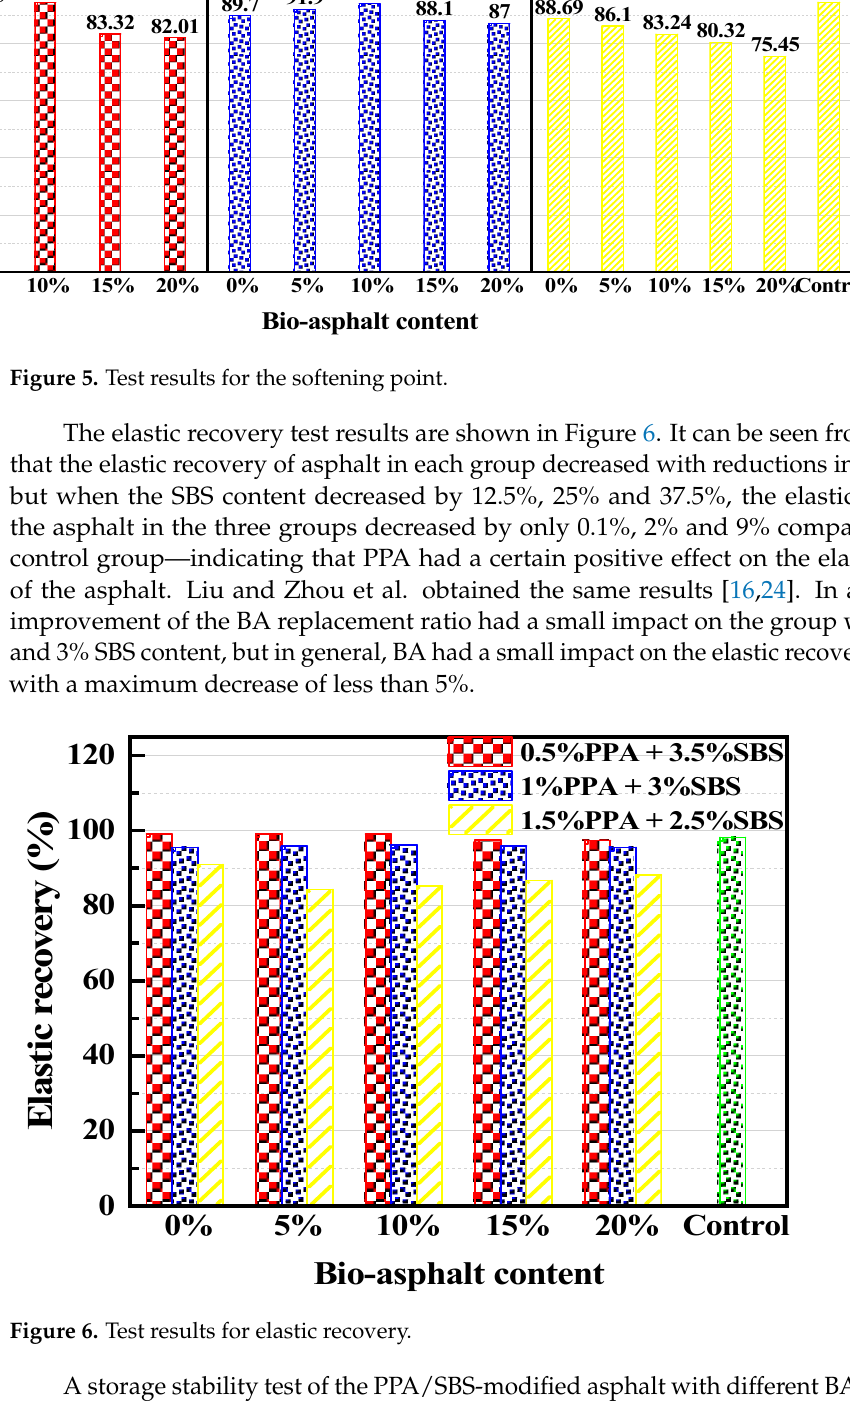
SBS Figure 7. Test results for segregation. The rotational viscosity test results are shown in Figure 8. According to the figure, decreasing SBS content can significantly reduce asphalt viscosity. In addition, by compar- ing the viscosity of modified asphalt in the same group with different dosages of BA, it was found that increasing the dosages of BA will improve the viscosity of asphalt to a